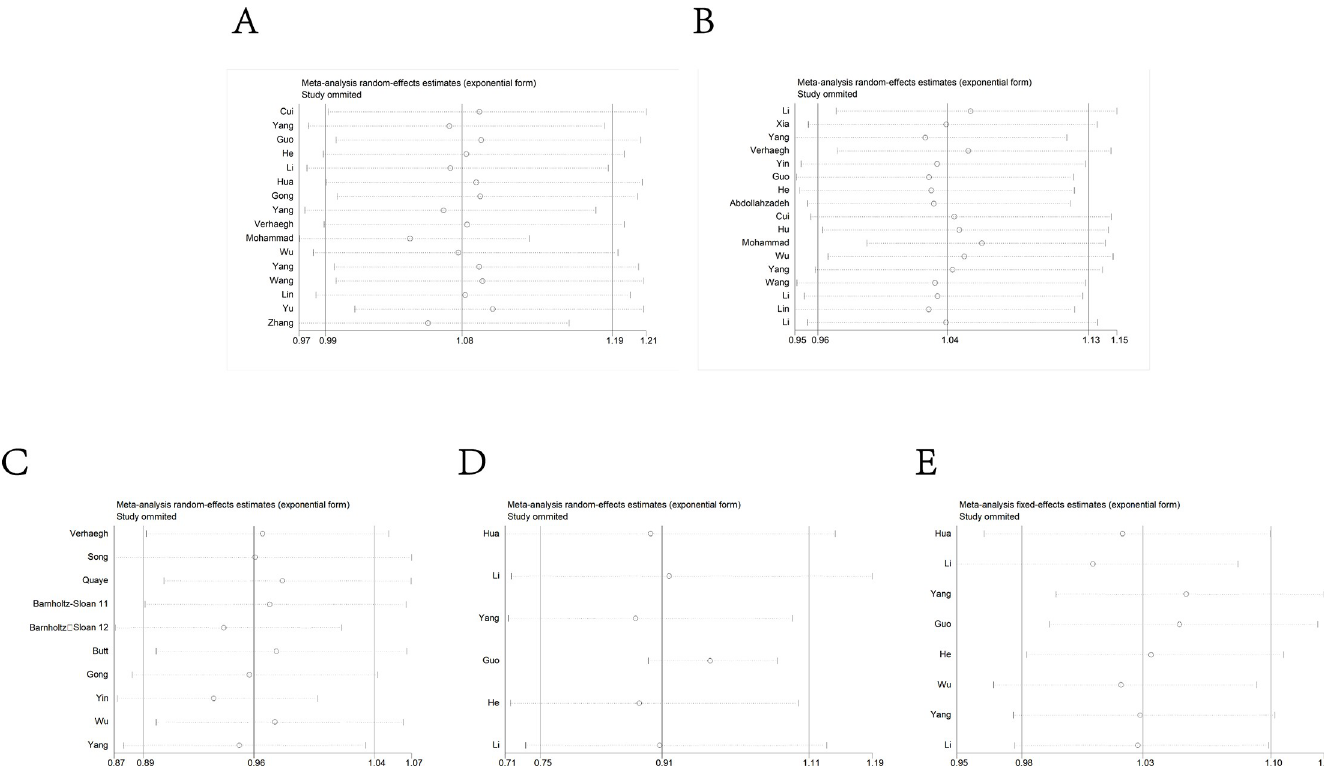
Fig 7. Sensitivity analysis under the allele model. A: rs2839698; B: rs217727; C: rs2107425; D: rs2735971; E: rs3024270.